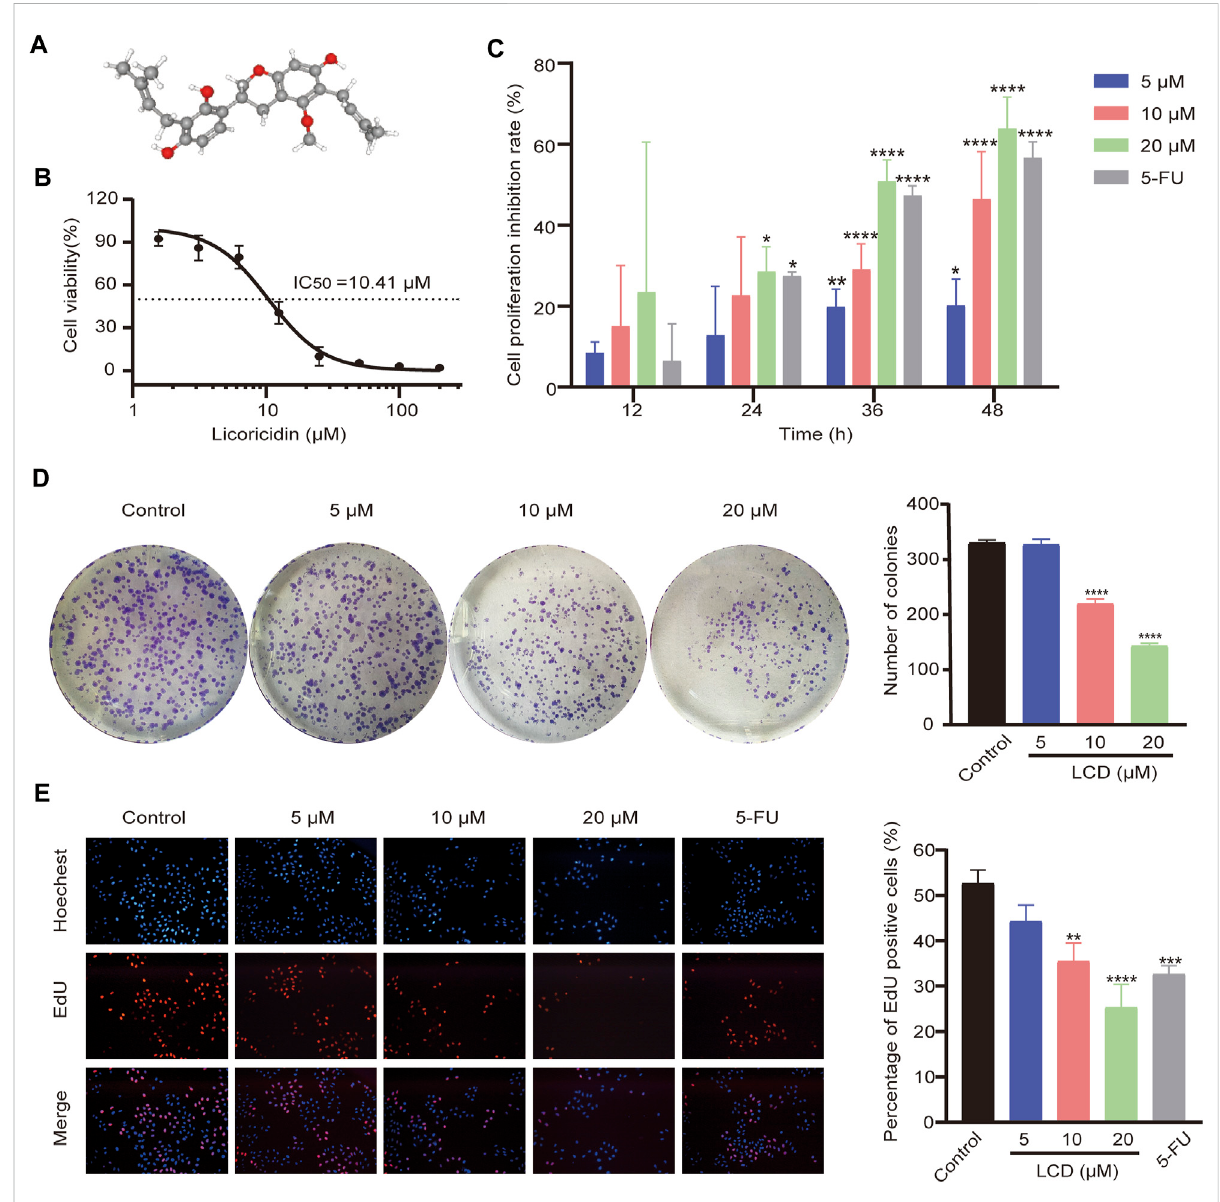
FIGURE 1 Chemical structure of licoricidin and its inhibitory effect on the proliferation of MGC-803 cells. (A) Three-dimensional (3D) chemical structure oflicoricidin,downloadedfromPubchem(https://pubchem.ncbi.nlm.nih.gov/compound/480865). (B) Half-maximalinhibitoryconcentration(IC 50 ) of licoricidin on MCG-803 cells. Cells were treated with licoricidin (1.5625, 3.125, 6.25, 12.5, 25, 50, 100, and 200 μ M) for 24 h. OD values at 450 nm were detected by CCK-8 assay, and then the IC 50 was calculated by Graphpad Prism 8.0. (C) Licoricidin inhibited the proliferation of MGC-803 cells via CCK-8assay.Cellswereadministratedwithlicoricidin(5 μ M,10,and20 μ M)for12,24,36,and48 h. (D) ColonyformationofMGC-803cells treated with licoricidin. (E) EdU-positive cells detected by the EdU staining test (×100). MGC-803 cells were exposed to licoricidin (5 μ M, 10,